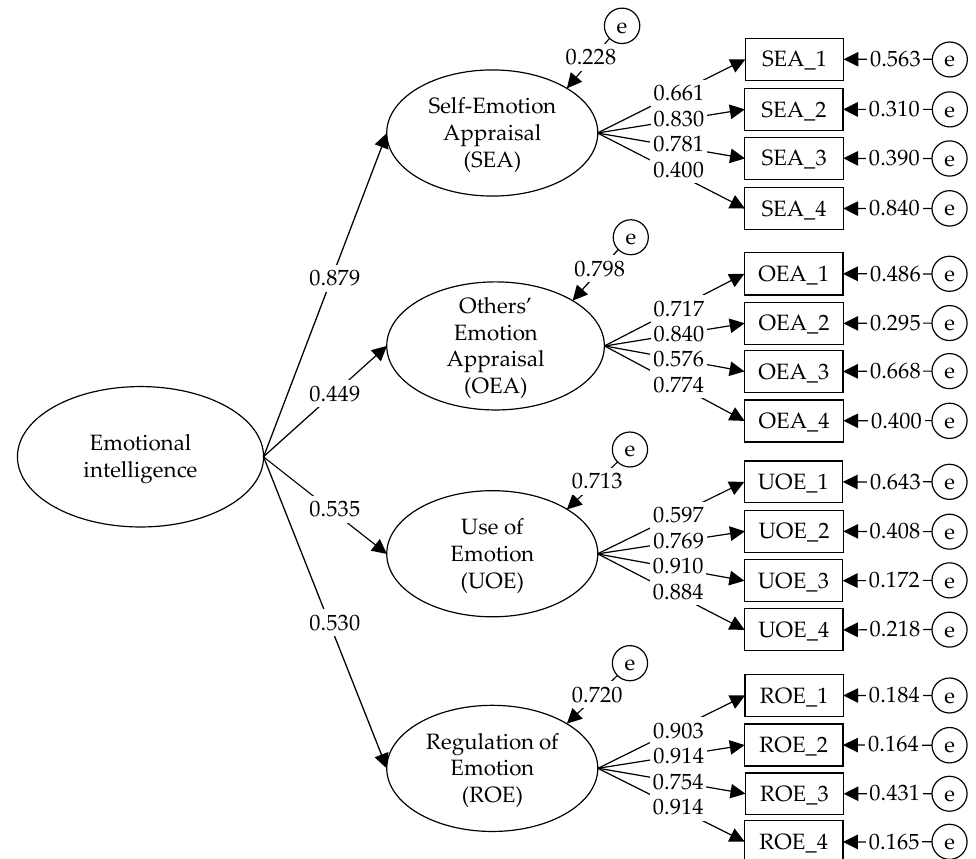
Figure 1. Factorial structure of the higher-order model of the WLEIS.